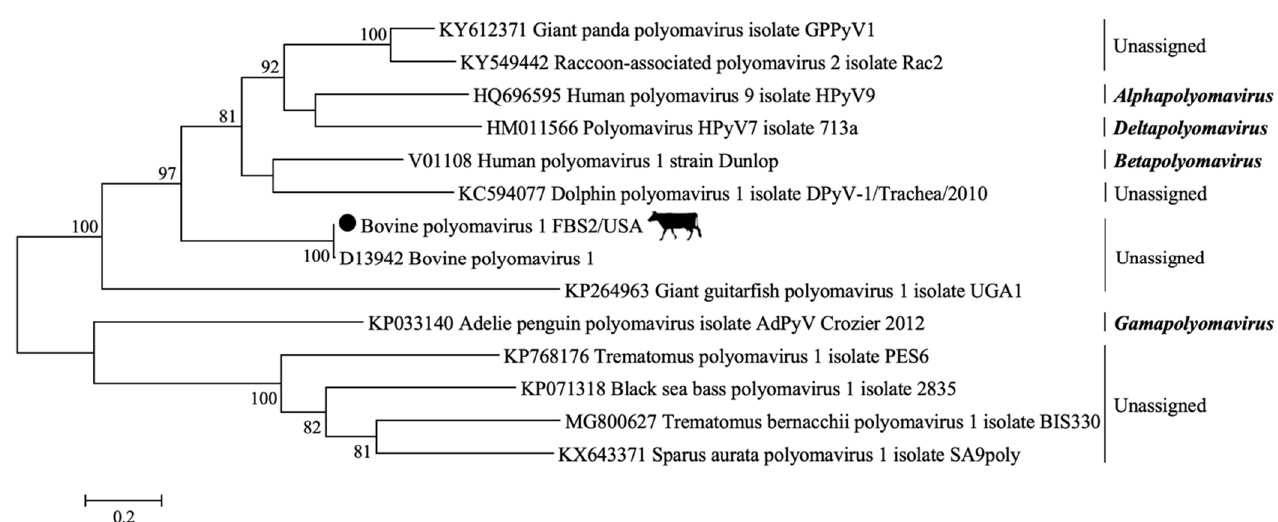
Figure 2. Phylogenetic tree based on the coding sequence of the polyomavirus large tumor antigen gene. The MEGA6 app suite was used for the phylogeny inference using the Maximum-Likelihood (ML) method based on General Time Reversible (GTR) model. Analyses were conducted with 1000 bootstrap replicates. The polyomavirus reference sequences described in the International Committee on Taxonomy of Viruses were retrieved from the GenBank database. The retrieved bovine polyomavirus 1 (BPyV-1) sequence is represented by the black dot and it was deposited in GenBank under the accession number MZ520135.